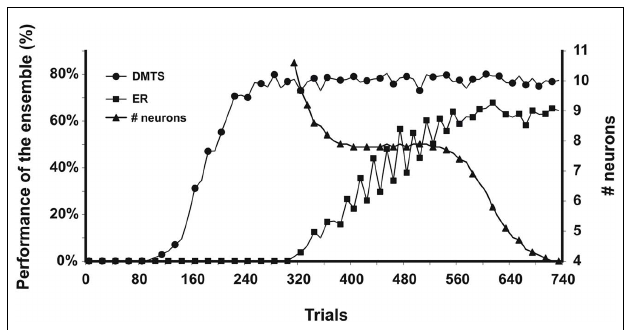
FIGURE 6 | Performance in DMTS and equivalence relations (ER) are shown as a function of training trials. Both performances were calculated as the percentage of models of the ensemble that perform at 100% in DMTS and over criteria (80%) in equivalence relations.The right axis shows the number of neurons necessary to codify the rules tested in the equivalence relation.